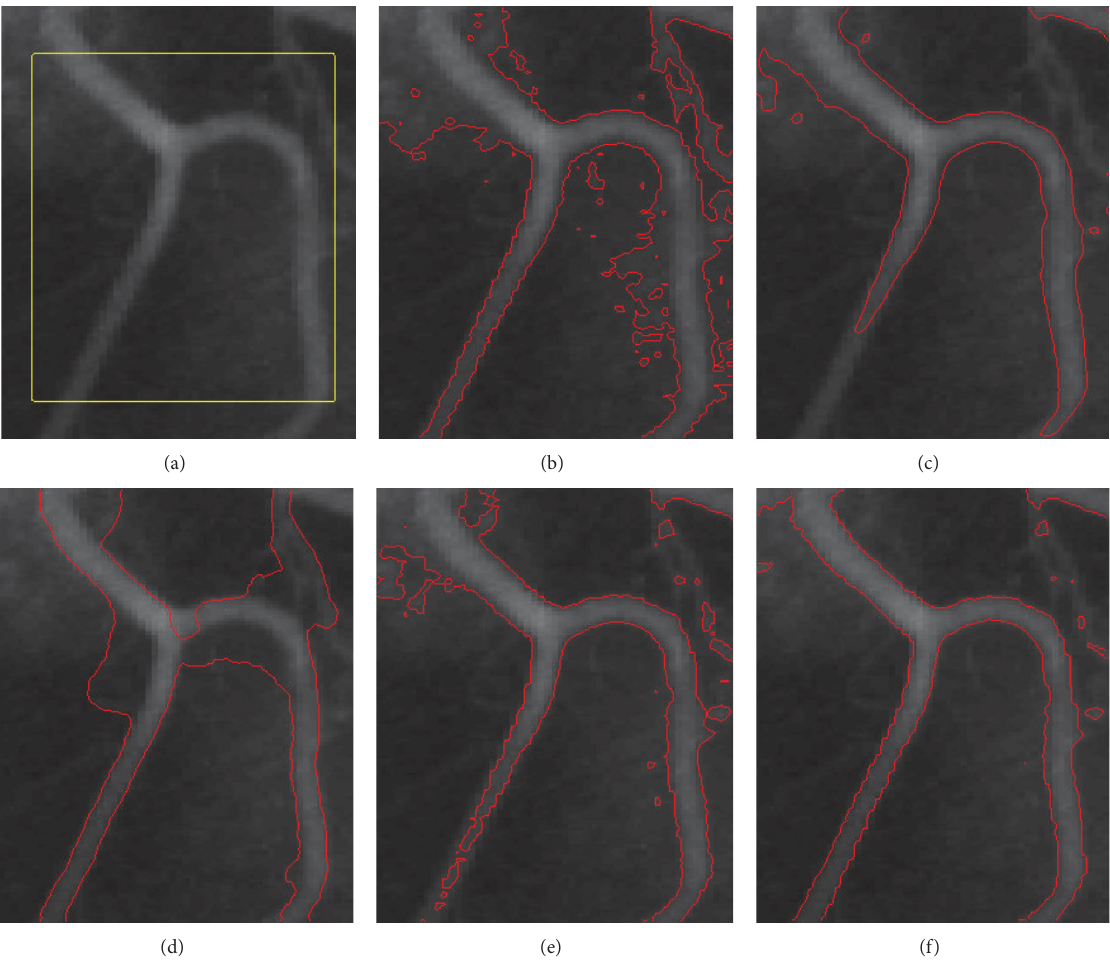
Figure 15: Segmentation results on the first vessel image: (a) the initial contour, (b) the CV model result, (c) the GACV model result, (d) the DRLSE model result, (e) the FAC model result, and (f) the LFAC model